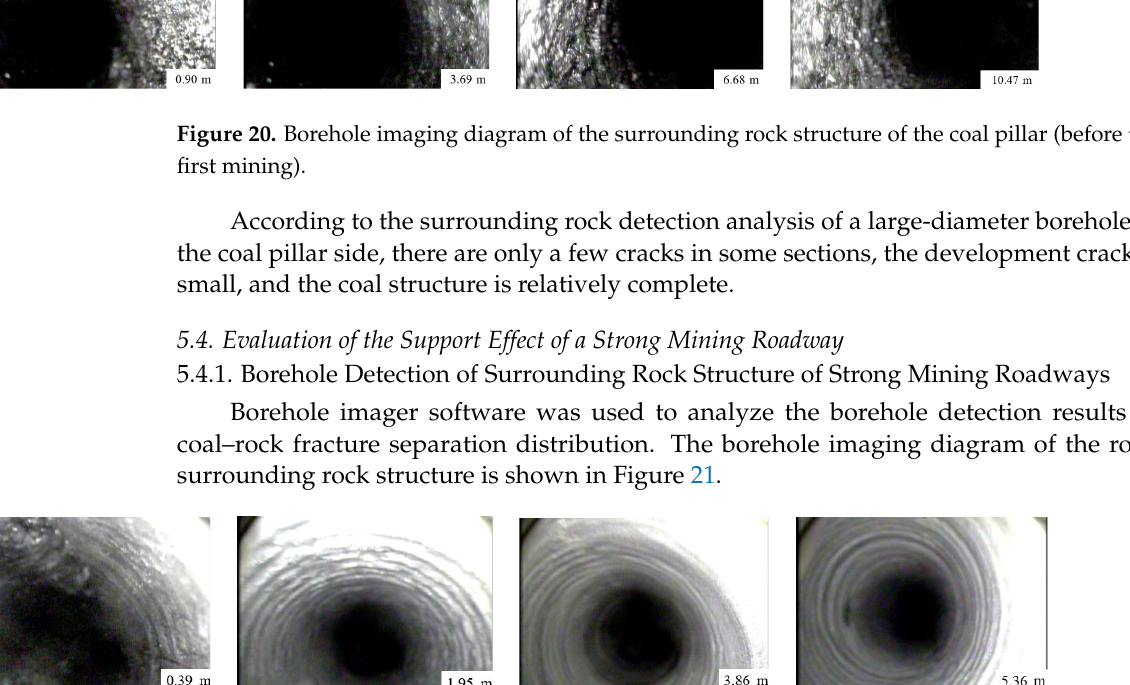
( d ) Figure 22. Maintenance effect of RAR 23205: ( a ) pillar sidewall; ( b ) pillar sidewall cracking in some place s ; ( c ) roof reinforcement with cable beams; ( d ) overall maintenance effect. 6. New Roadways’ Layout Optimization and Control Countermeasures 1.